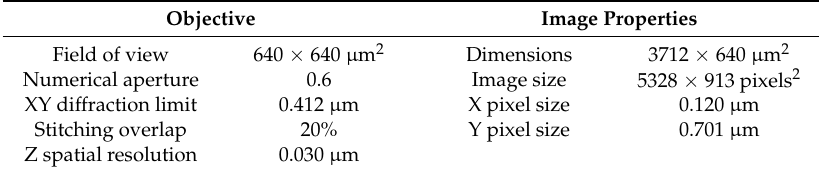
Table 2. Step height measurement uncertainty budget for COP and PMMA in injection molding (IM) and ICM, of a nominal grooves’ height of 17.3 µ m. Measurements are calibrated with a gauge step of 14.45 µ